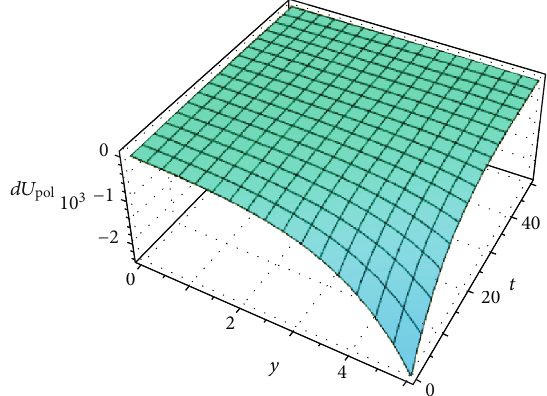
Figure 10: The internal energy change dU